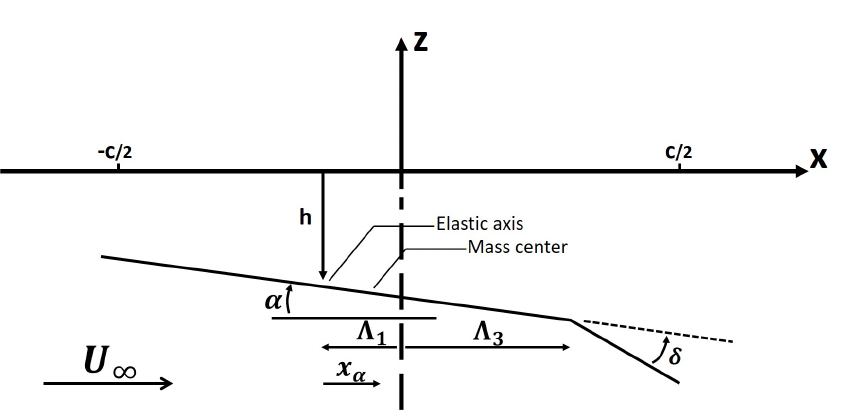
Figure 1. Airfoil section with 3 degrees of